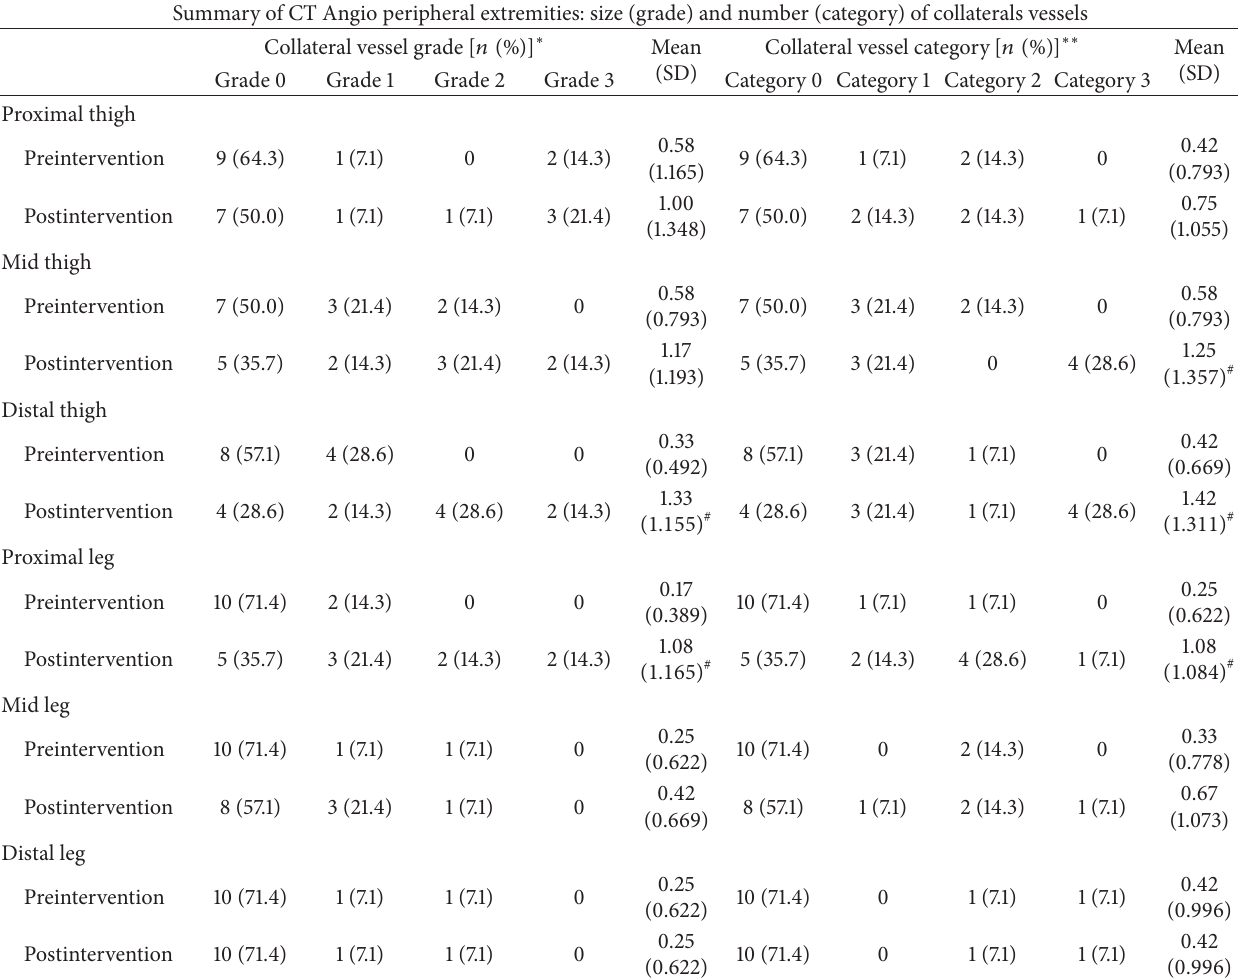
Table 4: Summary of CT Angiography category and grading results. Summary of CT Angio peripheral extremities: size (grade) and number (category) of collaterals